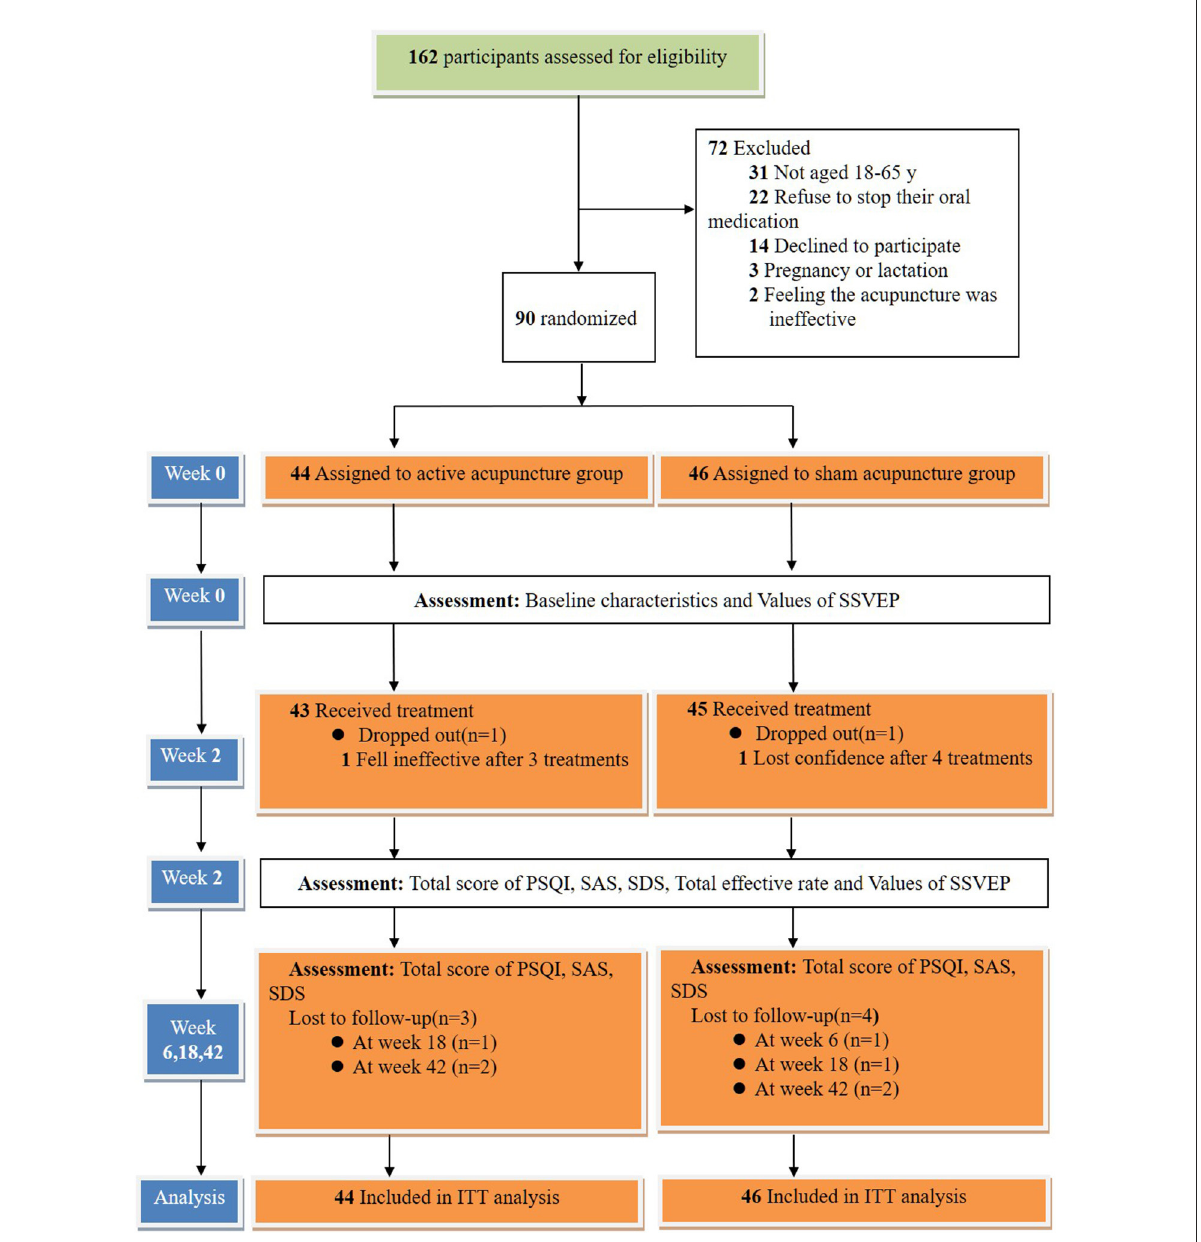
FIGURE3 Trial flow diagram (The Screening, Enrolment, Randomization, Interventions, Follow-up, and Analysis). ITT indicates intention to